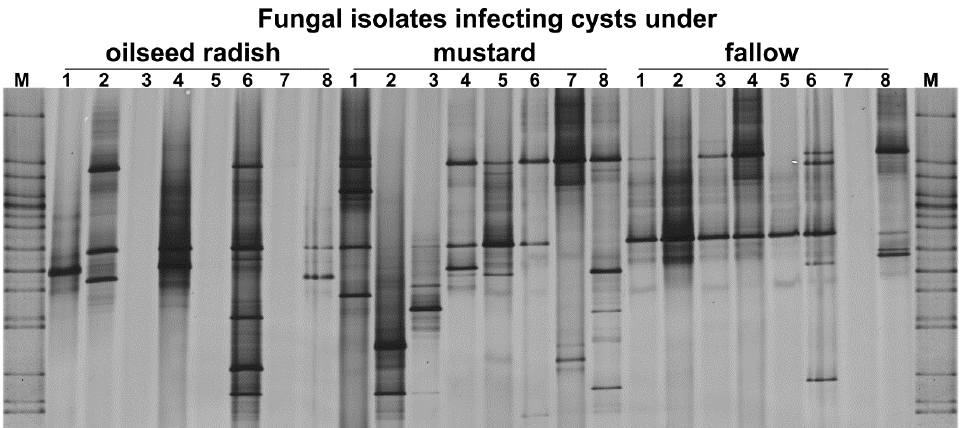
Figure 6. Gross Munzel, DGGE fingerprints of ITS gene fragments amplified from 10 pooled cysts per replicate sample (the number above each lane refers to the replicate number for each treatment) from the soil of three cover crop treatments in the year prior to the sugar beet production. M: Marker including the ITS fragments of fungal isolates.